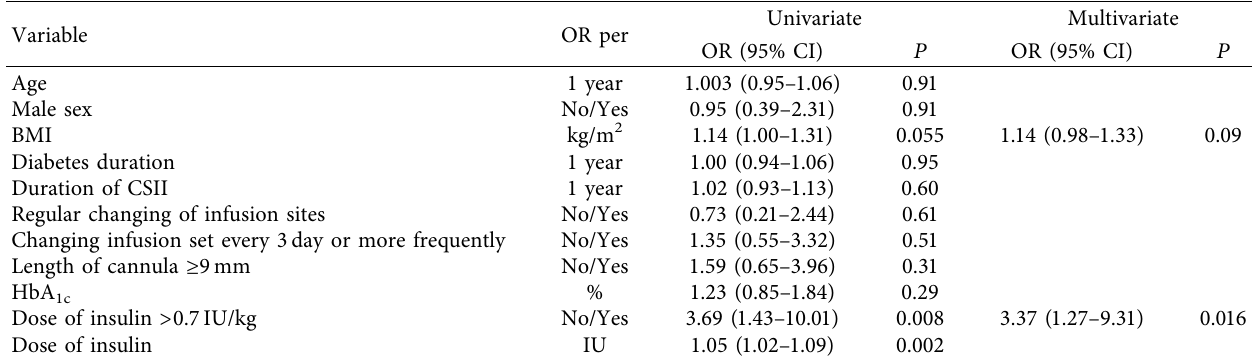
Table 2: Univariate and multivariate models for risk factors of 5 and more LH